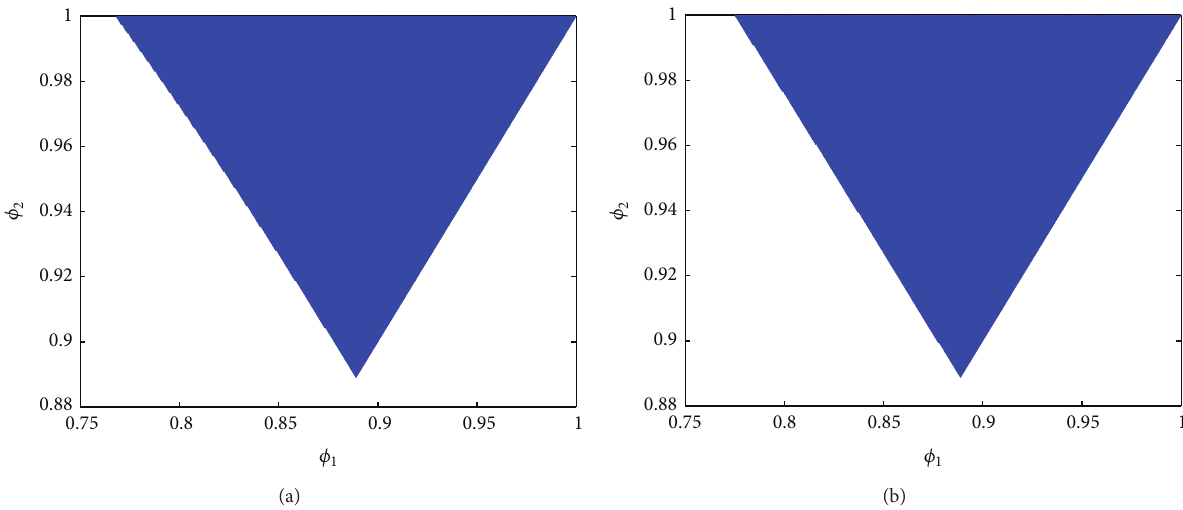
Figure 1: The range of values 𝜙 1 , 𝜙 2 when ‖𝐷 −1 𝐶‖ 1 < 1 (a) or ‖𝐷 −1 𝐶‖ 2 < 1 (b).